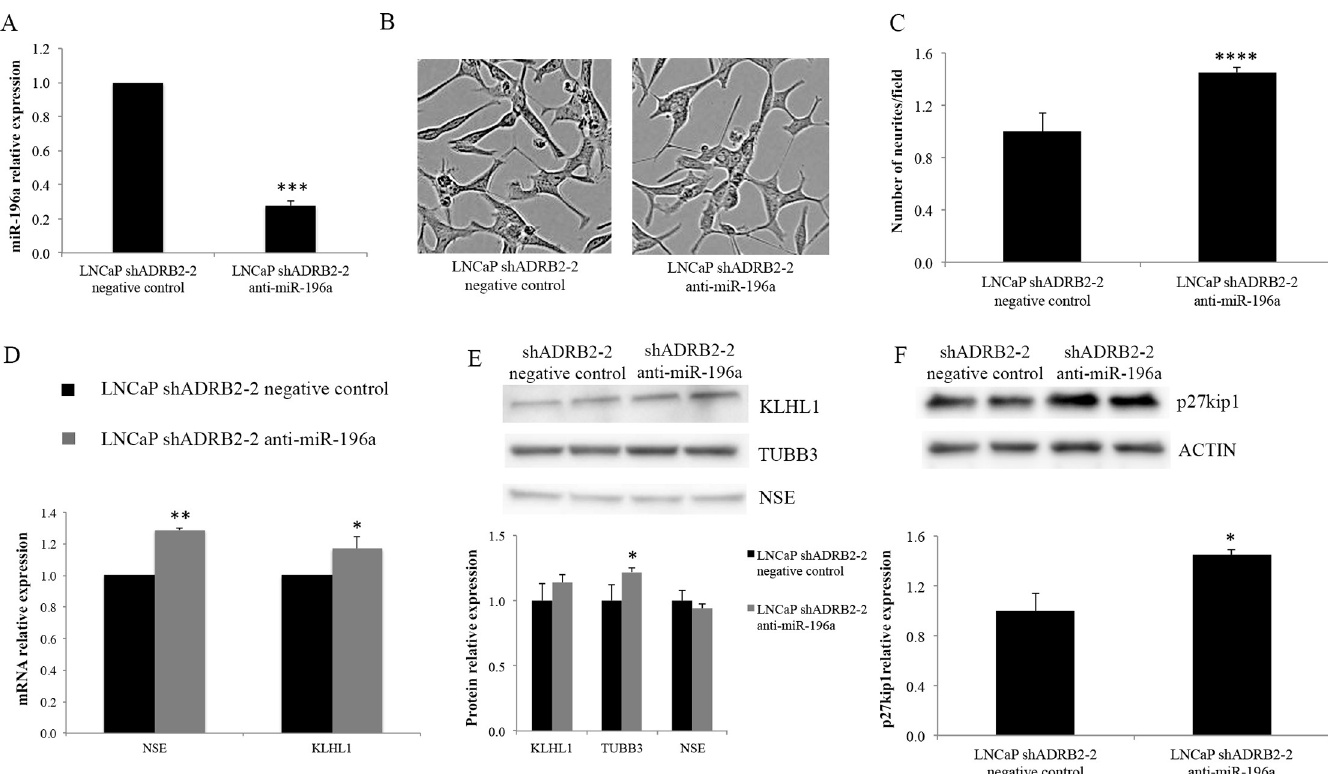
Fig 3. miR-196a effect in neurite outgrowth. (A) qRT-PCR analysis of miR-196a in LNCaP shADRB2-2 cells transfected with anti-miR-196a and anti-miR negative control miRNA. miR-196a expression was evaluated after 3 days in 10% CSS medium and normalized to the reference gene miR-16-5p. n = 4. (B) Representative fields from phase-contrast light microscopy images of LNCaP shADRB2-2 negative control and anti-miR-196a cells cultured in 10% CSS for 3 days. (C) Quantification of neurite-like outgrowths in LNCaP shADRB2-2 negative control and anti-miR-196a cells cultured in 10% CSS for 3 days. Bars represent the average number ± SD of neurite-like outgrowths per field. p < 0.0001. Neurite-like outgrowths were quantified manually in 20 cells of 10 fields (200 cells per condition) in three different experiments. (D) qRT-PCR analysis of NSE and KLHL1 mRNA levels in LNCaP shADRB2-2 cells transfected with anti-miR-196a and anti-miR negative control miRNA. mRNA levels were evaluated after 3 days in 10% CSS medium and normalized to the reference gene POLR2A. The experiment was performed two times and a representative experiment showing the mean ± SD of three replicates is presented. (E) Western blot analysis of neuroendrocrine markers in LNCaP shADRB2-2 negative control and anti-miR-196a cells. Quantification of three experiments with duplicates and representative gels are shown. (F) Western blot analysis of p27 kip1 in LNCaP shADRB2-2 negative control and anti-miR-196a cells. Quantification of three experiments with duplicates and a representative gel are shown.